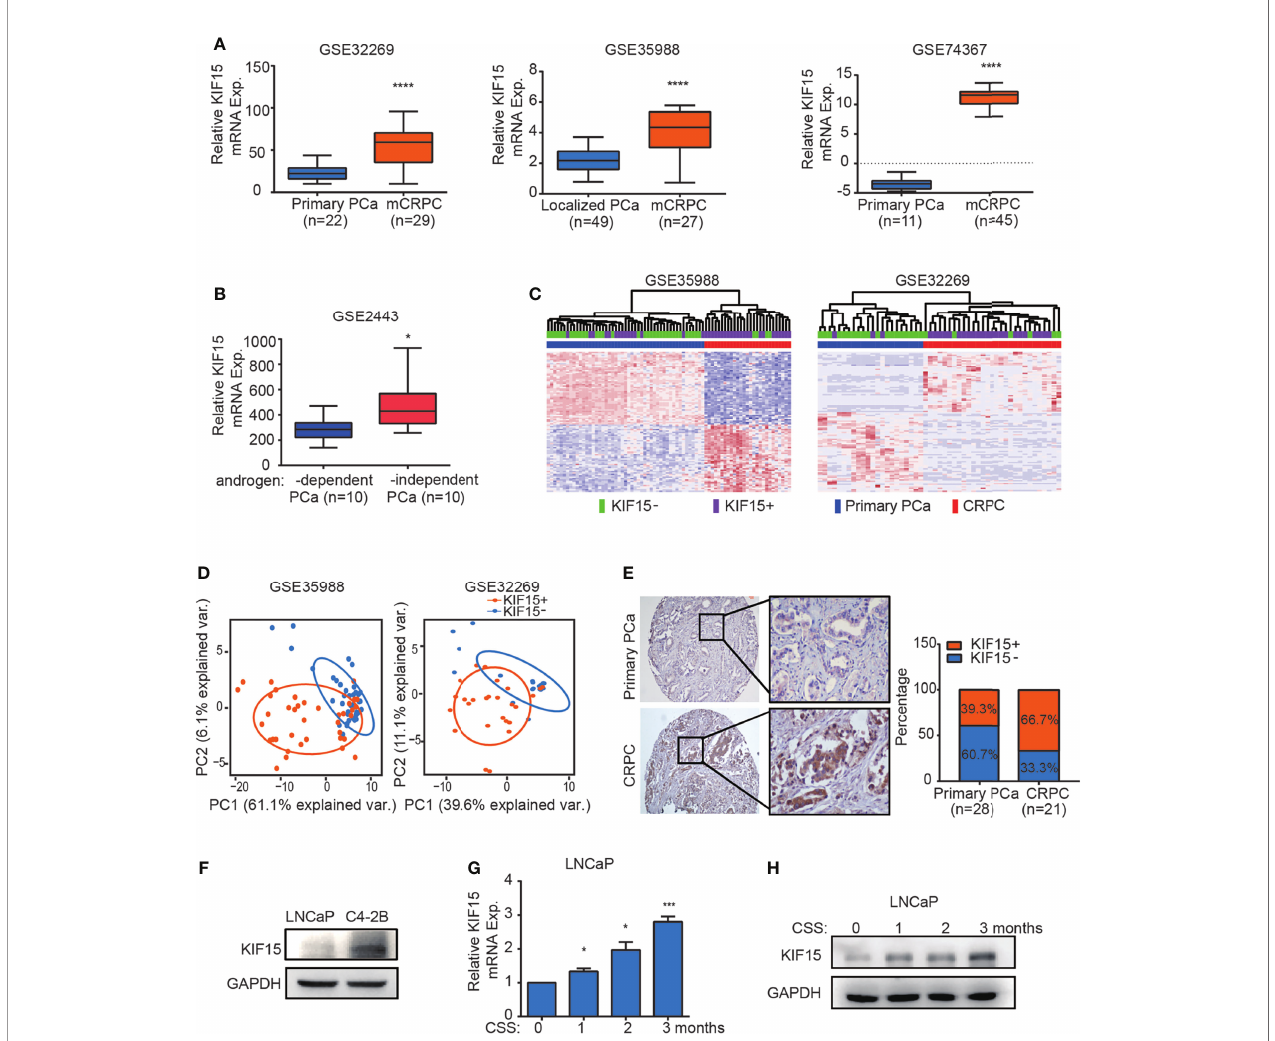
FIGURE 1 | KIF15 is overexpressed in CRPC. (A) Expression of KIF15 in primary PCa and CRPC tissues taken from publicly available datasets of GSE32269 (left), GSE35988 (middle) and GSE74367 (right). KIF15 expression was analyzed in a) 22 samples with primary PCa from hormone-naive patients, and 29 samples with CRPC (GSE32269); b) 49 samples with localized PCa, and 27 samples with metastatic CRPC (GSE35988); c) 11 samples with primary PCa tumor and 45 samples with CRPC metastases from 32 patients (GSE74367). The statistical analysis was based on Student ’ s t test. **** P < 0.0001. (B) KIF15 expression in androgen-dependent and independent PCa. KIF15 expression was analyzed in 10 samples with androgen-dependent primary PCa and 10 samples with androgen-independent primary PCa (GSE2443). The statistical analysis was based on Student ’ s t test. * P < 0.05. (C) Unsupervised clustering analyses of GSE35988 (left) and GSE32269 (right) datasets based on differentially expressed genes of primary PCa and CRPC tissues. Patients statue are shown in the annotation column. Patients were categorized according to KIF15 expression or PCa risk assessment. Green: patients with low KIF15 expression (50% cutoff; KIF15-); Purple: patients with high KIF15 expression (50% cutoff; KIF15 +); Blue: patients with primary PCa (Primary PCa); Red: patients with CRPC. (D) PCA analysis of unique CRPC-upregulated gene expression pattern between KIF15+ (high KIF15 expression, 50% cutoff) and KIF15- (low KIF15 expression, 50% cutoff) of PCa patients from GSE35988 and GSE32269 datasets. CRPC-upregulated genes were obtained from the top100 high expressed genes in CRPC compared with primary PCa in each dataset. Each point represents a patient. (E) The percentage of KIF15 expression distributed in PCa cases in Qilu Hospital with primary PCa or CRPC. Left panel: representative IHC images for KIF15 expression. Right panel: the percentage of KIF15 expression distributed in 49 PCa cases in Qilu Hospital with primary PCa or CRPC. (F) KIF15 levels in LNCaP and C4-2B cells analyzed by Western blot assay. LNCaP and C4-2B cells were harvested and whole lysates were subjected to Western blot. (G, H) Levels of KIF15 mRNA (G) and protein (H) in LNCaP cells with prolonged androgen-deprivation treatment. qRT-PCR and Western blot analysis were performed to detect KIF15 expression in LNCaP cells after androgen-deprived treatment in charcoal-stripped medium for the indicated time periods. CSS, Charcoal stripped fetal bovine serum; Exp., Expression; * P < 0.05; *** P < 0.001 vs. 0